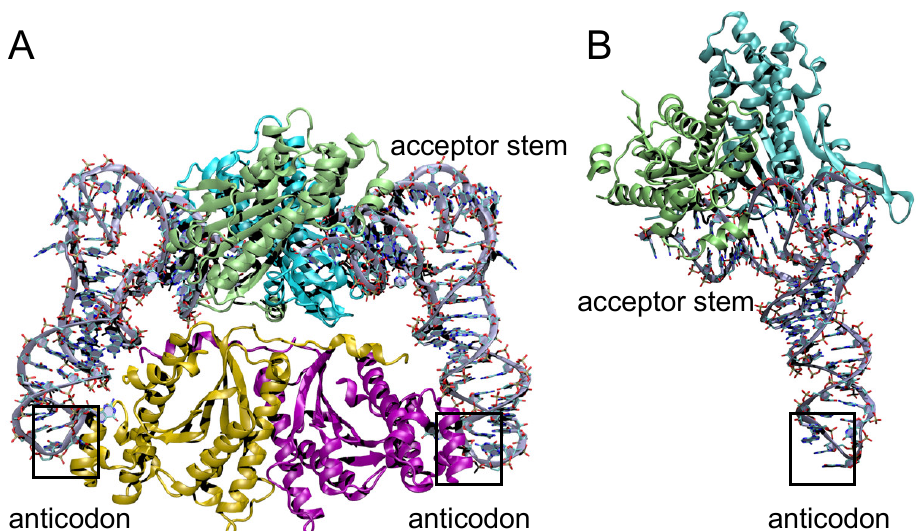
Figure 6. Structural comparison of Thg1 and TLPs. ( A ) The tetrameric eukaryotic Thg1 (monomers in green, teal, yellow and pink) coordinates two tRNAs molecules (grey) and binds both to the anticodon and the acceptor stem. ( B ) Methanosarcina acetivorans TLP forms a dimer (monomers in green and teal) coordinating on tRNA (grey). While the dimer binds the acceptor stem and T arm of its tRNA substrate, the anticodon loop is not coordinated by TLP